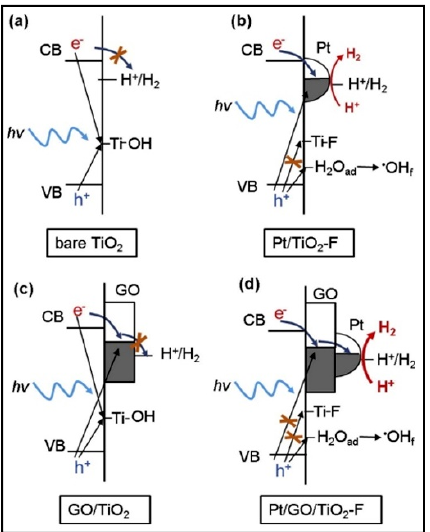
Scheme 5. Schematic illustrations of interfacial charge transfer and recombination occurring on ( a )